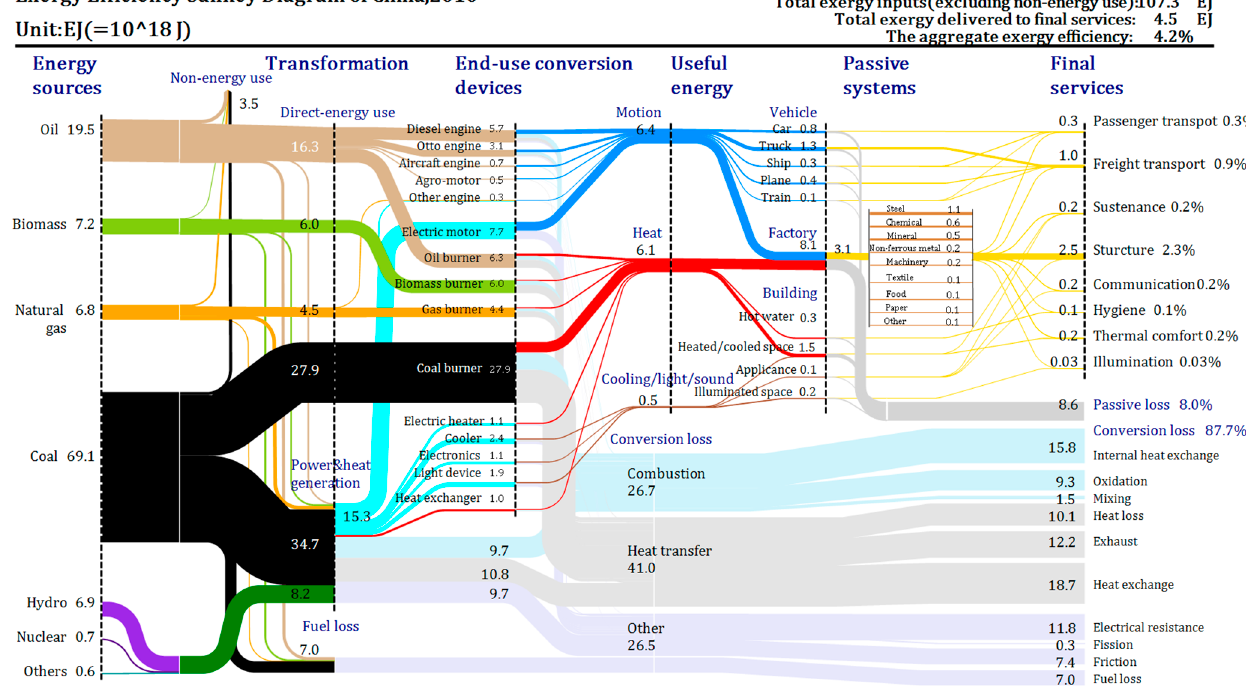
Figure 6. Exergy efficiency Sankey diagram from the energy source to final service of China in 2010.